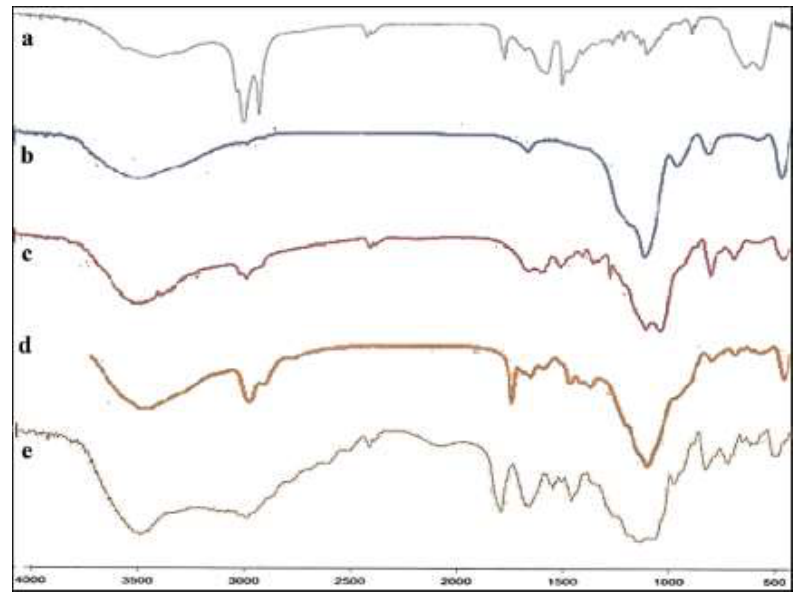
Fig. 3. FT-IR spectra of (a) MAs (Magnetic Assembles), (b) HSNP-OH, (c) HSNP-NH